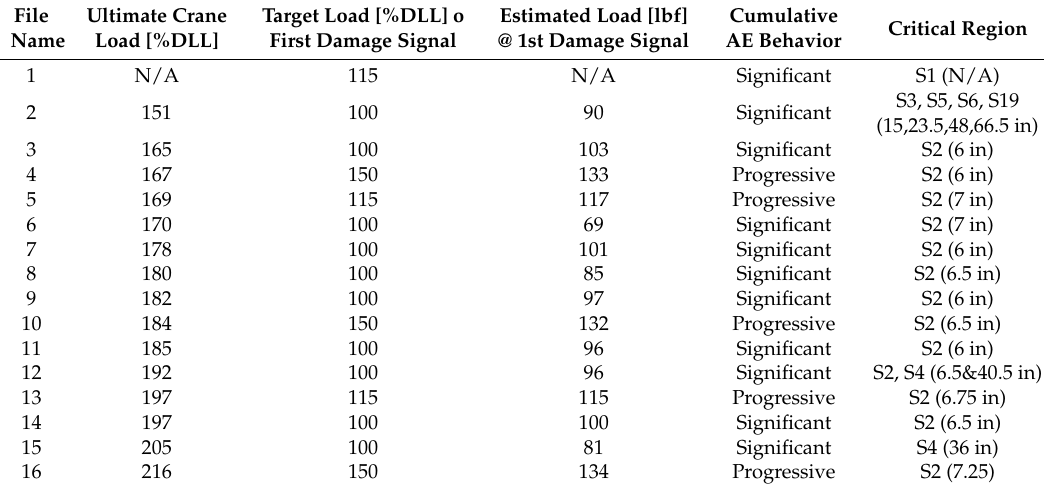
Table 3. Results